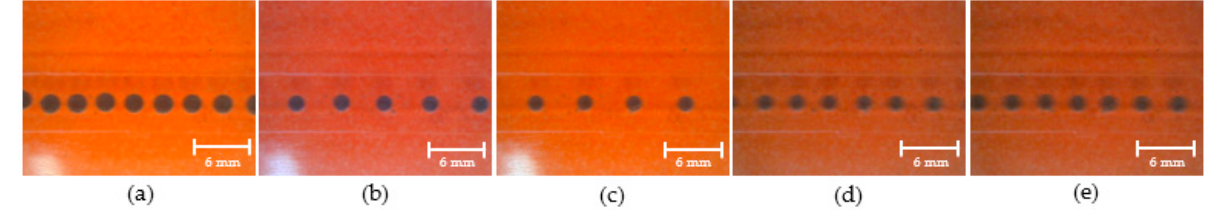
Figure 9. Visible variation of brightness levels: ( a ) t = 15 s; ( b ) t = 615 s; ( c ) t = 1215 s; ( d ) t = 1815 s; ( e ) t = 2415 s.